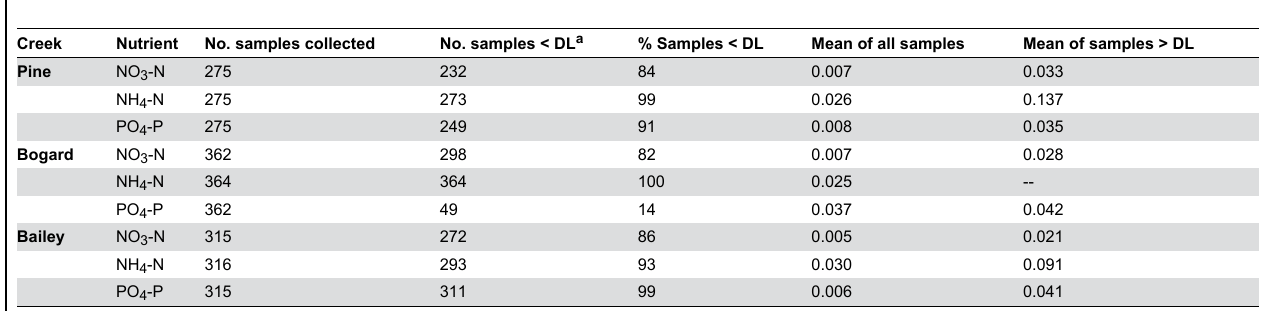
Table 1. Results of nutrient analyses at Pine, Bogard, and Bailey